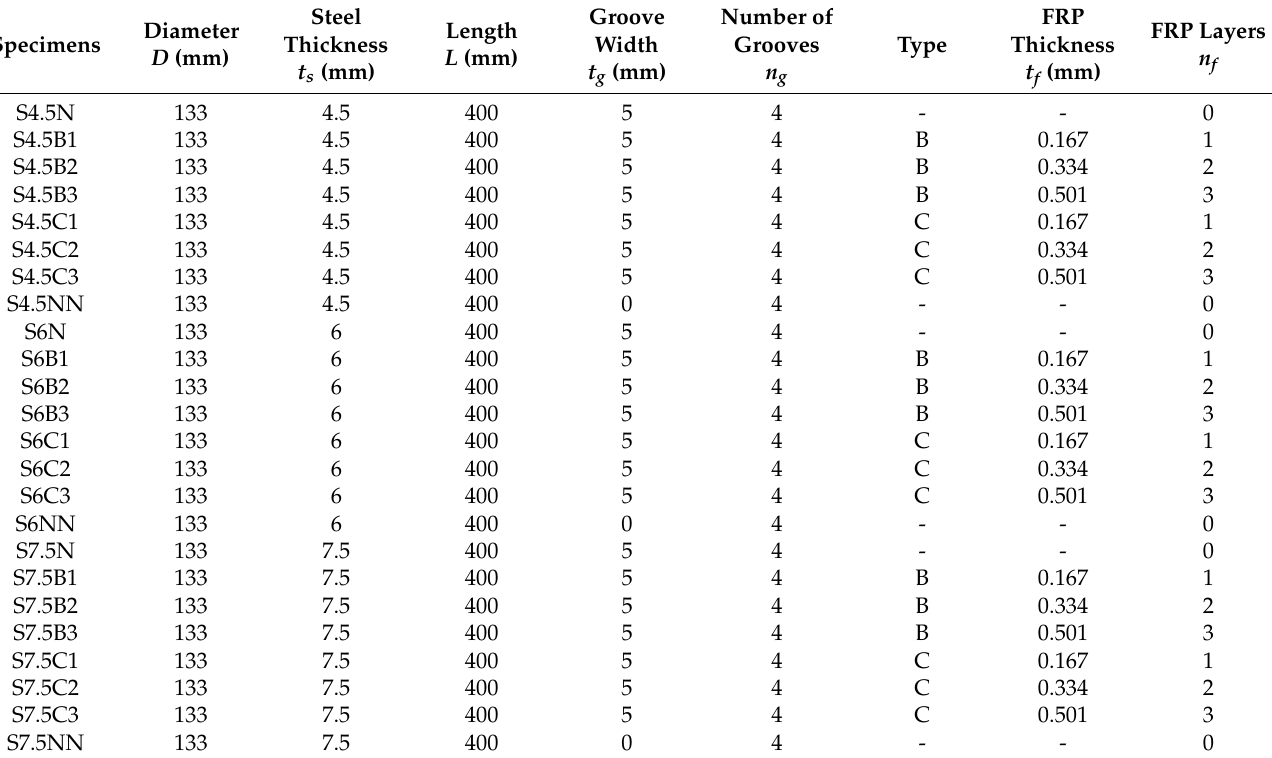
Table 1. Test variables of all the